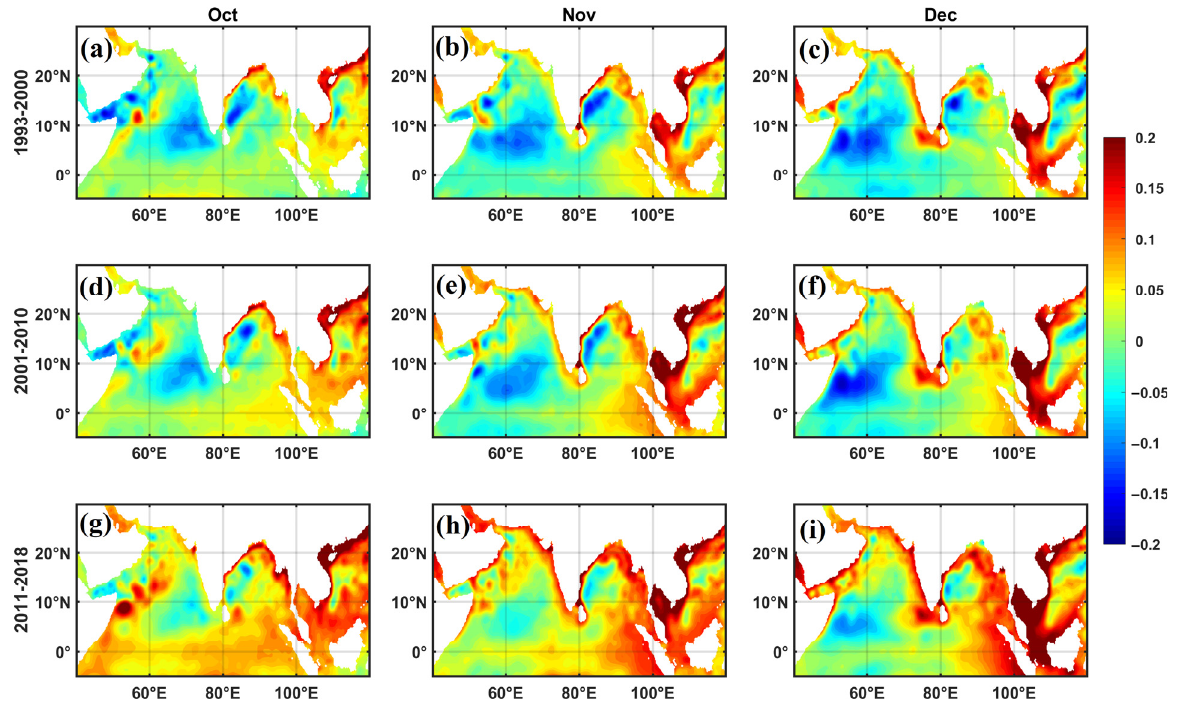
Figure 6. The decadal variation in SSHA (m, color shading) representing the propagation of second downwelling Kelvin wave in the North Indian Ocean during October, November and December.